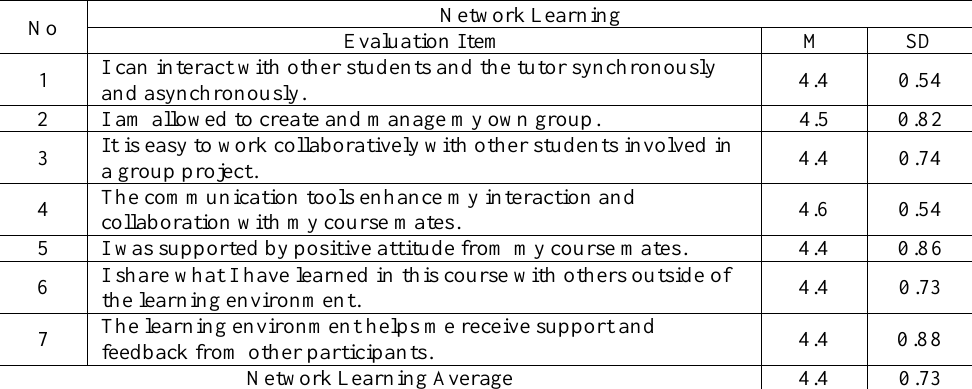
Descriptive Results of Network Learning